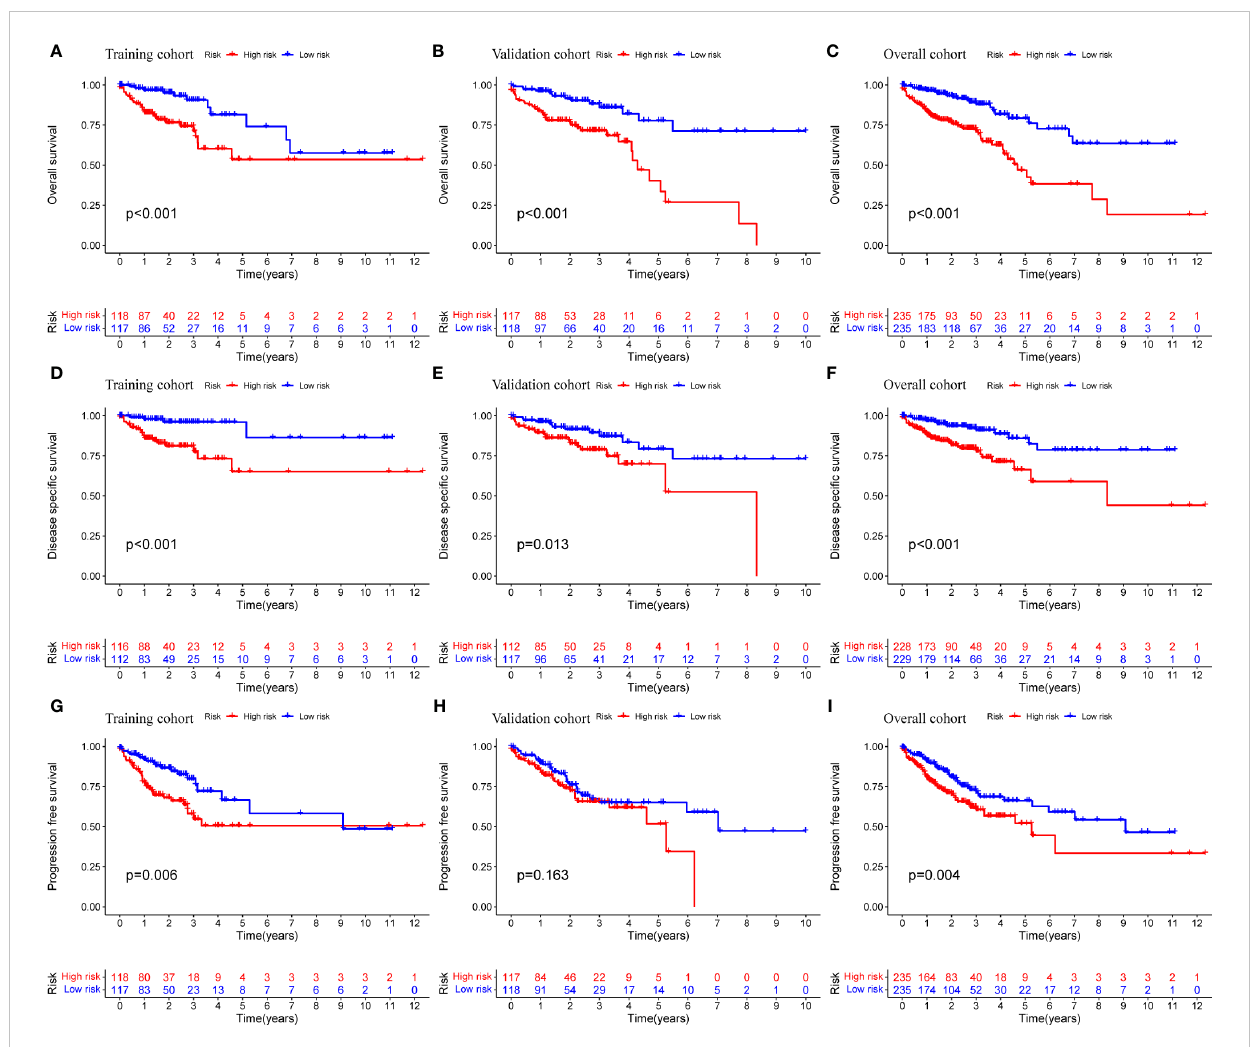
FIGURE 4 Prognostic analysis of MRLncRI. (A – C) Kaplan-Meier survival curve analysis of training cohort, validation cohort and whole cohort OS. (D – F) Kaplan- Meier survival curve analysis of training cohort, validation cohort and whole cohort DSS. (G – I) Kaplan-Meier survival curve analysis of training cohort, validation cohort and whole cohort